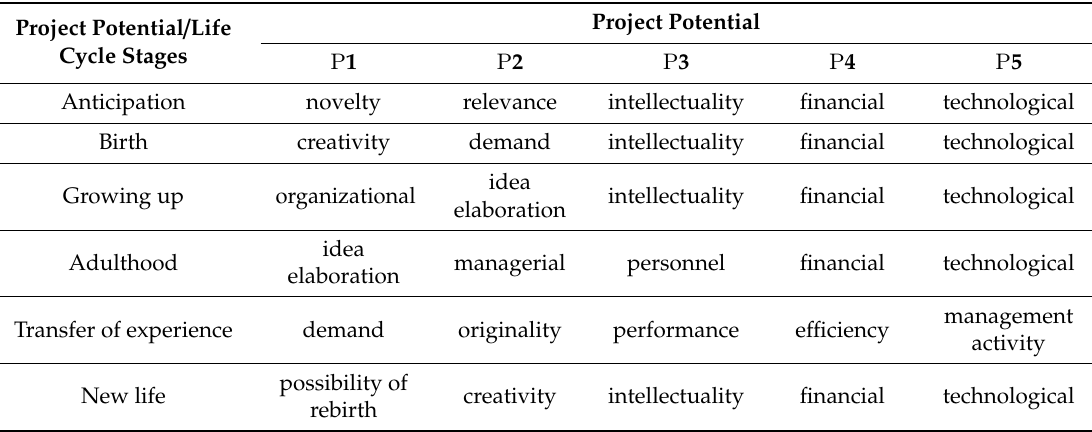
Table 4. Assessment groups of project potential at life cycle